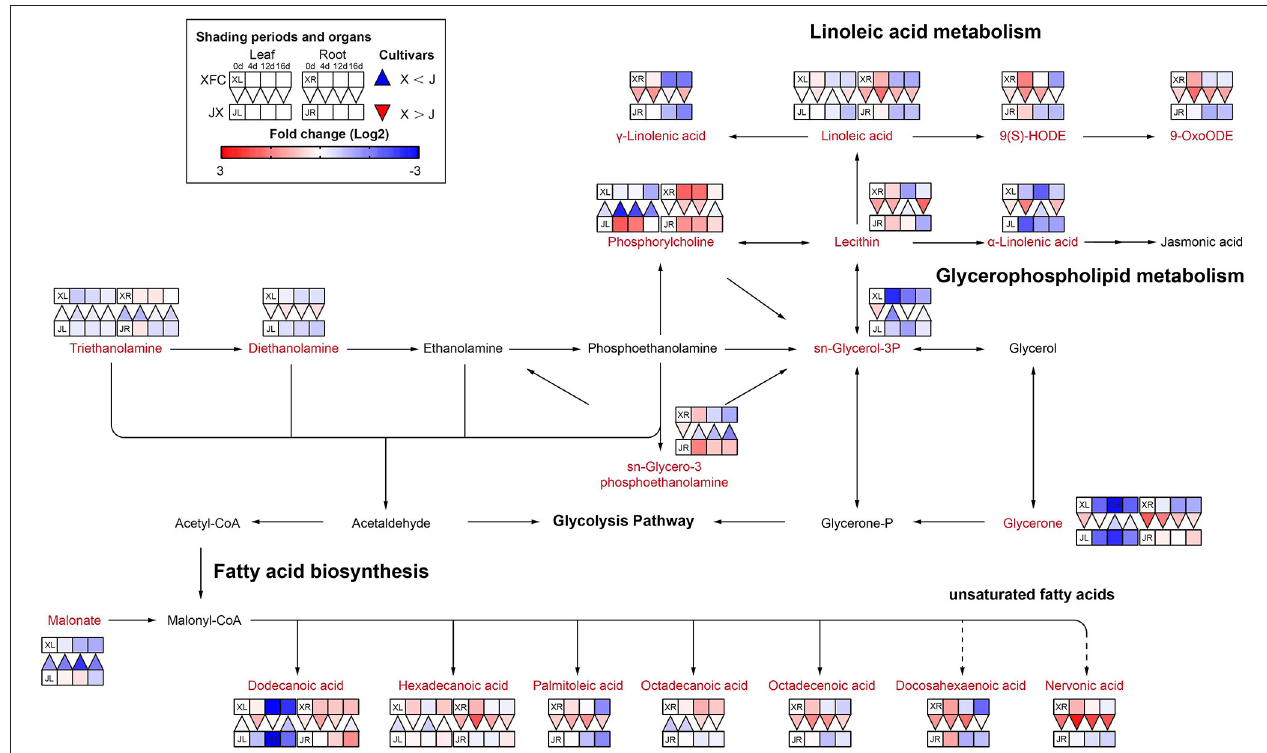
FIGURE 8 | The metabolite differences during lipid metabolism in the two tea cultivars under different shading periods. The identified metabolites are marked with a red color. In the legend, the squares at two lines express the different cultivars, “Xiangfeicui” (XFC) and “Jinxuan” (JX). The squares at eight columns express the different shading periods. The squares in the left part represent the leaves and the right part represents the roots. Blue indicates relatively low and red indicates relatively high intensity. The red triangle indicates relatively higher intensity of metabolites in XFC (X) than in JX (J), and the inverted blue triangle indicates relatively lower intensity of metabolites in XFC (X) than in JX (J). The degree of change was described with the depth of color, and the depth of the colors is based on the log2-fold change value between the samples. XL, leaf of “Xiangfeicui”; XR, root of “Xiangfeicui”; JL, leaf of “Jinxuan”; JR, root of